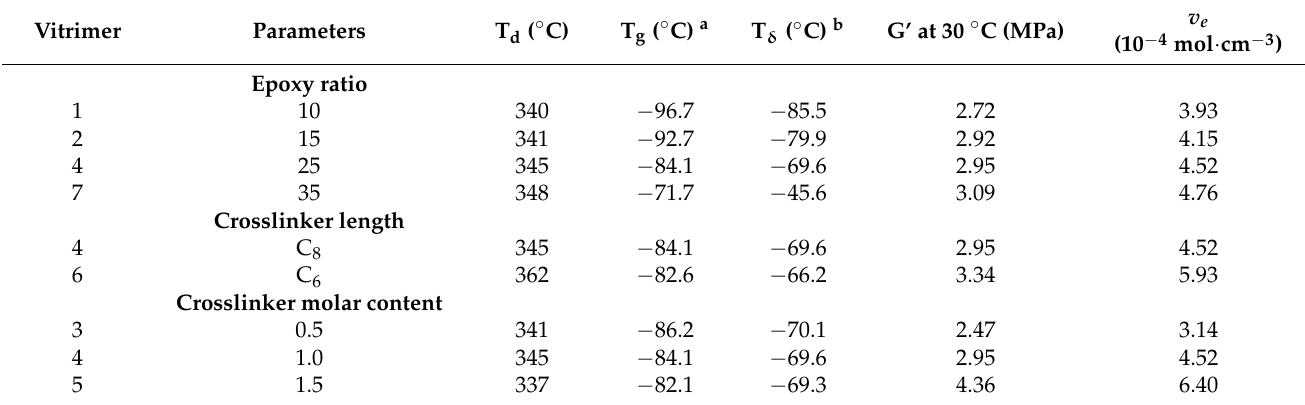
Table 2. The physical properties of PB vitrimers.